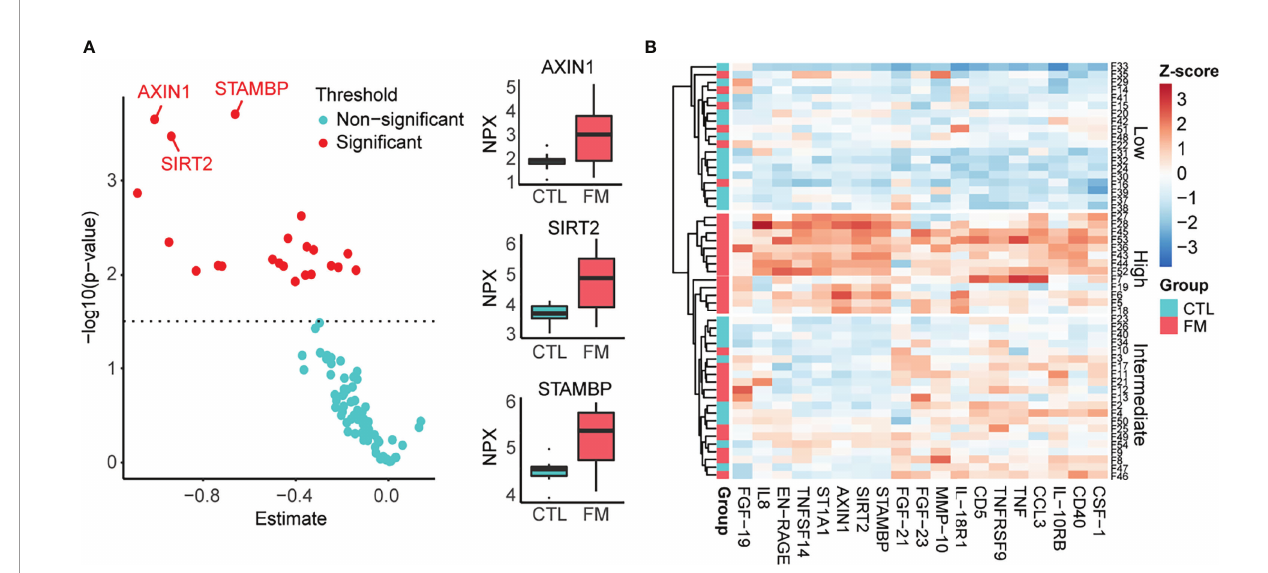
FIGURE 3 | Relative levels of 92 soluble in fl ammatory proteins in sera of 30 FM patients vs. 23 matched control individuals, using Olink In fl ammatory panel. (A) Graph showing relative increase of the 19 proteins (red spots) in the FM patient group. The most marked differences were identi fi ed for AXIN1, SIRT2 and STAMBP. (B) Heatmap showing increased levels of 19 in fl ammatory proteins in the group of FM patients. Individuals with low protein levels belong mainly to the control group (Low). A subset of patients shows a more pronounced increase in levels of in fl ammatory protein